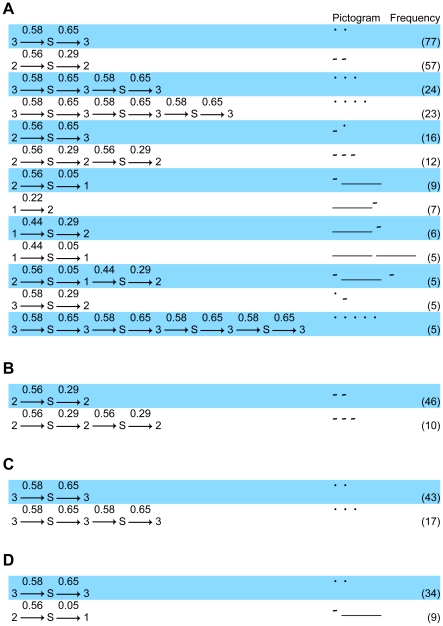
Frequently appearing rat syllables.(A) Ten syllables with the highest frequency from all data. The characters sandwiching the arrows indicate the cluster number or silence (denoted as “S”). The numbers above the arrows are probabilities for the transition. At the pictogram column, “_____”, “-”, “ ˙”, and “ ” represent clusters 1, 2, 3, and silence, respectively. (B, C, and D) Top 2 syllables with the highest frequency in feeding (B), moving (C), and fighting (D).